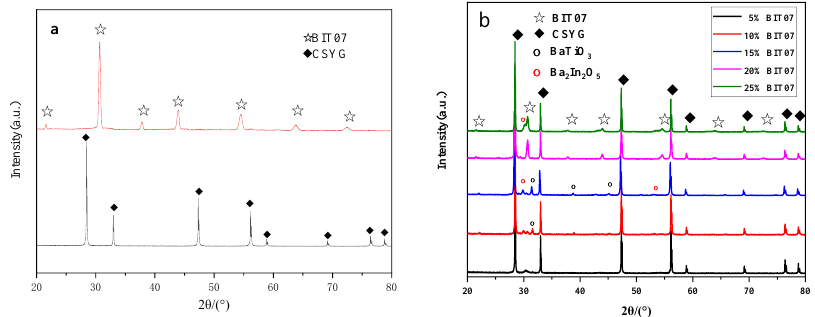
Figure 3. XRD pattern of ( a ) CSYG and BIT07, ( b ) CSYG-BIT07 composite materials.